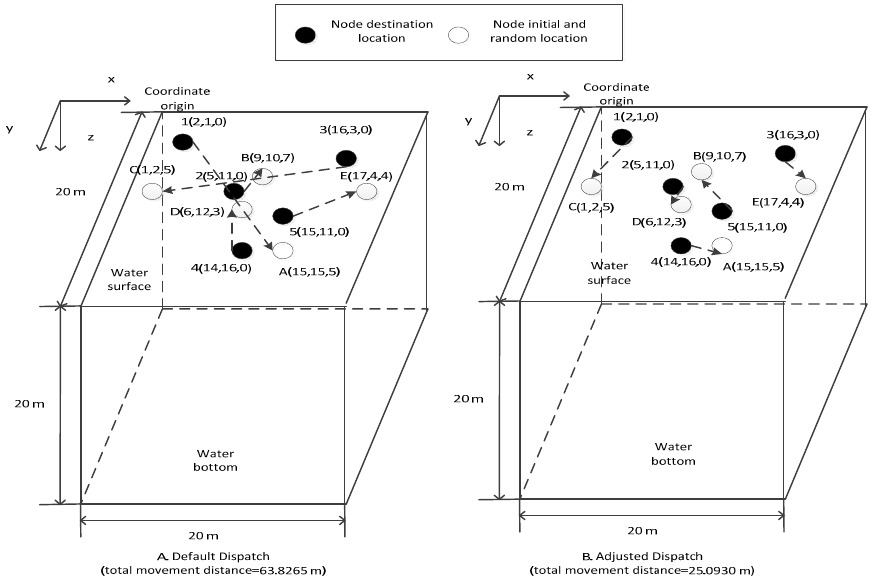
Figure 4. Total movement distance comparison for default and adjusted dispatches.